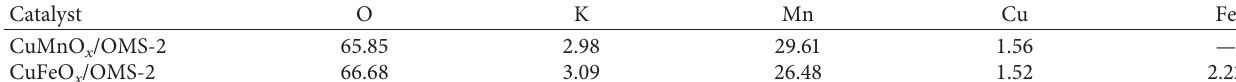
Figure 3: SEM-mapping and EDS images of CuFeO Table 1: Elemental composition in the atomic percentage of the catalysts by EDS.